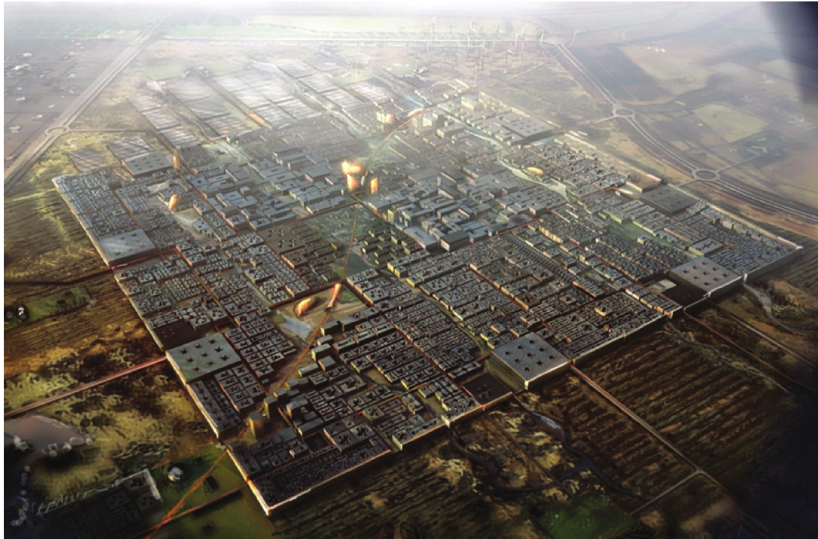
Figure 5. Rendering of Masdar. A perfectly boundaried realm of projected sus- tainability © Forgemind ArchiMedia. Image use granted under creative commons - Attribution 2.0 Generic (CC BY